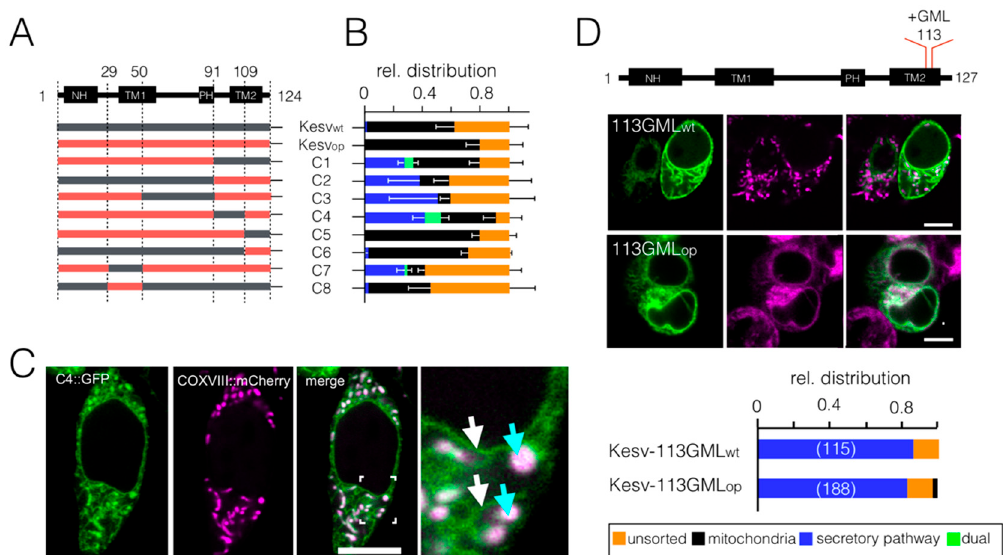
Figure 4. Complex sorting of the Kesv channel and its mutant in HEK293 cells transfected with chimera of genes with wt and optimized codons. ( A ) Schematic domain architecture of the Kesv channel monomer with transmembrane α -helixes including the N-terminal helix (NH), outer (TM1) and inner (TM2) transmembrane domain and pore helix (PH) (central panel) (top) and composition of Chimeras C1 to C8 comprising parts of the Kesv wt (grey) and Kesv op genes (red). ( B ) Mean relative distribution ( ± SD; n = 3, n ≥ 120 cells per chimera) of channels in mitochondria (black), SP (blue) and unsorted channels (orange) in HEK293 cells transfected with corresponding genes. The green bars represent cells in which the channel was present within the same cell in the mitochondria and in the SP. ( C ) Fluorescent image of a HEK293 cell transfected with Chimera C4. The images show distribution of GFP tagged chimera (green, left column), mitochondrial marker COXVIII::mCherry (magenta, second column), and an overlay of magenta and green channel (third column). The part indicated in the overlay is magnified in the fourth column with blue arrows and white arrows indicating presence of GFP in SP (white arrow) and mitochondria (blue arrow), respectively. ( D ) Top: schematic domain architecture as in A indicating position 113 in which the AA motive GML was inserted in TM2. Central: fluorescent images of HEK293 cells transfected with Kesv113GML from wt (113GML wt ) or codon-optimized (113GML op ) gene. Images show: the GFP tagged channel (green, first column) and fluorescence from mitochondrial marker COXVIII::mCherry (magenta, top) or from ER marker, HDEL::mCherry (magenta, down) as well as overlay of magenta and green channels (third column). Bottom: relative distribution of channels in mitochondria (black), SP (blue) and unsorted channels (orange) in HEK293 cells (numbers in brackets) transfected with corresponding genes. Scale bar in ( C , D ) 10 μ m.